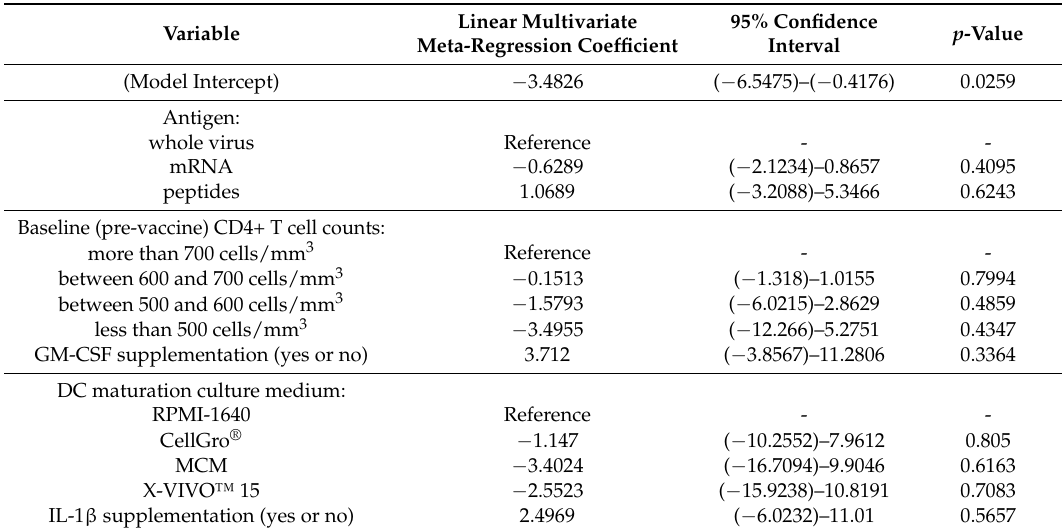
Table 6. Multivariate analysis for assessment of which factors were associated with treatment success rate of dendritic cell-based experimental anti-HIV